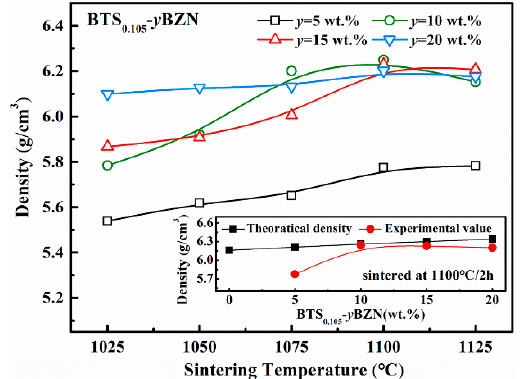
Figure 1. The change of density for BTS 0.105 − y BZN ceramics ( y = 5 wt.%, 10 wt.%, 15 wt.%, 20 wt.%) with respect to the sintering temperature. The inset shows the comparison between the theoretical and experimental densities.